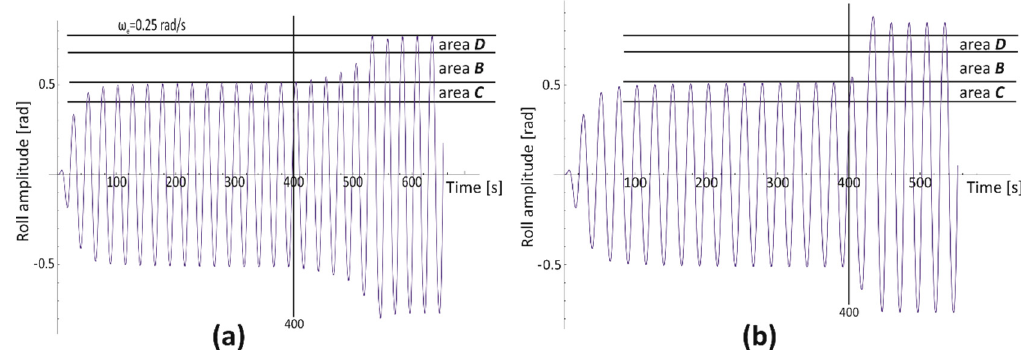
Figure 8. Roll time history for the LNG carrier ( T = 7.50 m, GM 0 = 4.00 m). Transitions between the bistability areas cause by change in the value of the exciting moment M w in 400 s of simulation. ( a )—change by 1%; ( b )—change by 10%.